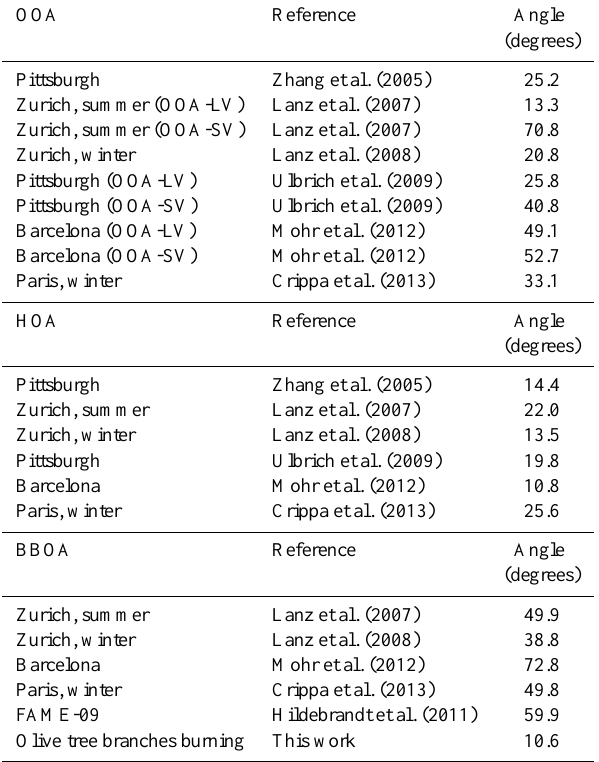
Table 3. Correlations between PMF factors from this work and PMF factors from previous studies.